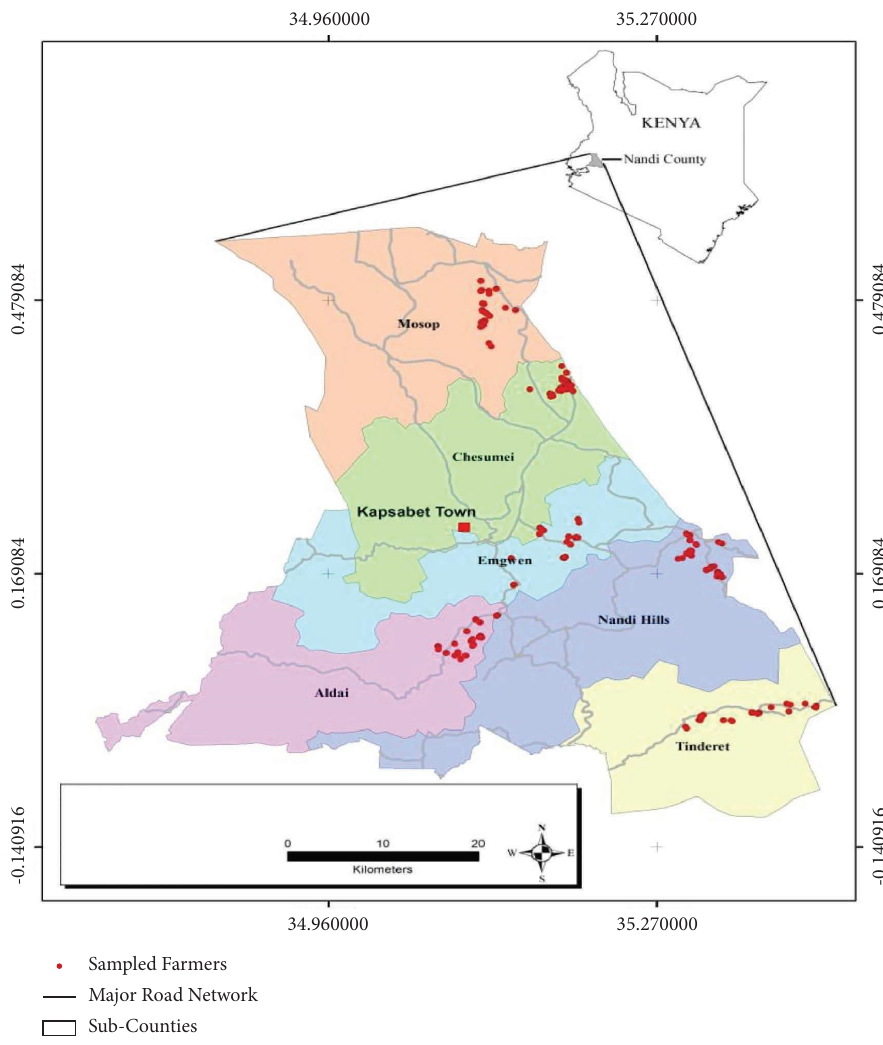
Figure 3: Spatial distribution of blood samples collected in Nandi county, Kenya (2019). Table 1: Summary of seroprevalence of Q fever in cattle, sheep, and goats in Nandi